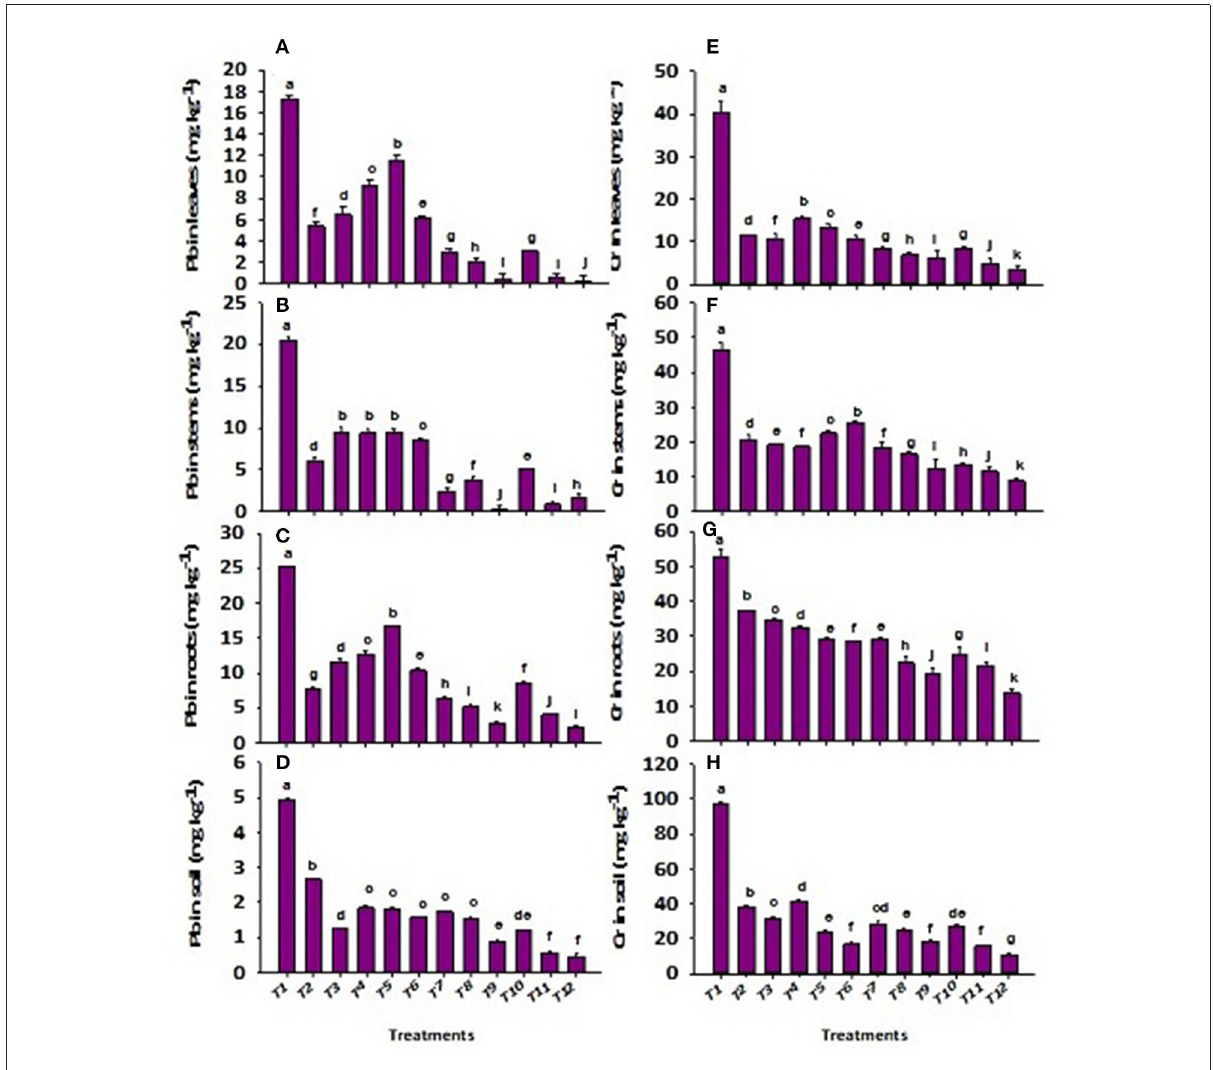
FIGURE2 Concentration of total lead (Pb) in (A) leaf, (B) stem, (C) root, (D) soil and chromium (Cr) in (E) leaf, (F) stem, (G) root and (H) soil of Solanum melongena L. plant grown in heavy metal contaminated soil (wastewater applied as stress) under different treatments such as T1 = Control; T2 = CP-Silica gel; T3 = ZnBc; T4 = B1; T5 = B2; T6 = B3; T7 = CP-Silica gel + B1; T8 = CP-Silica gel + B2; T9 = CP-Silica gel + B3; T10 = ZnBc + B1; T11 = ZnBc + B2 and T12 = ZnBc + B3. Values are the average of three replicates ± standard error (SE). Mean bars sharing similar